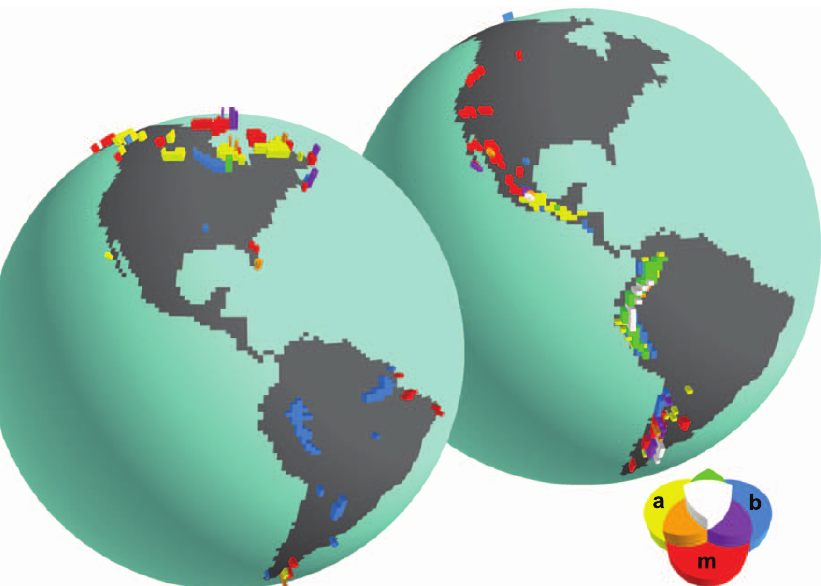
Figure 4. Geographic Distribution of Amphibian, Bird, and Mammal High and Low Beta-Diversity Overlap Spatial overlap in beta-diversity ( b sim-d ) for percentage sets of each taxon’s lowest (left) and highest (right) 2.5% of b sim-d grid cells is shown. Primary colors indicate grid cells unique to one taxon (yellow, amphibians; blue, birds; red, mammals), secondary colors indicate overlap between two groups, and white indicates overlap of all three groups. The height of the grid cells reflects the number of overlapping groups. Note the greater degree of spatial coincidence in high b sim-d than in low b sim-d .